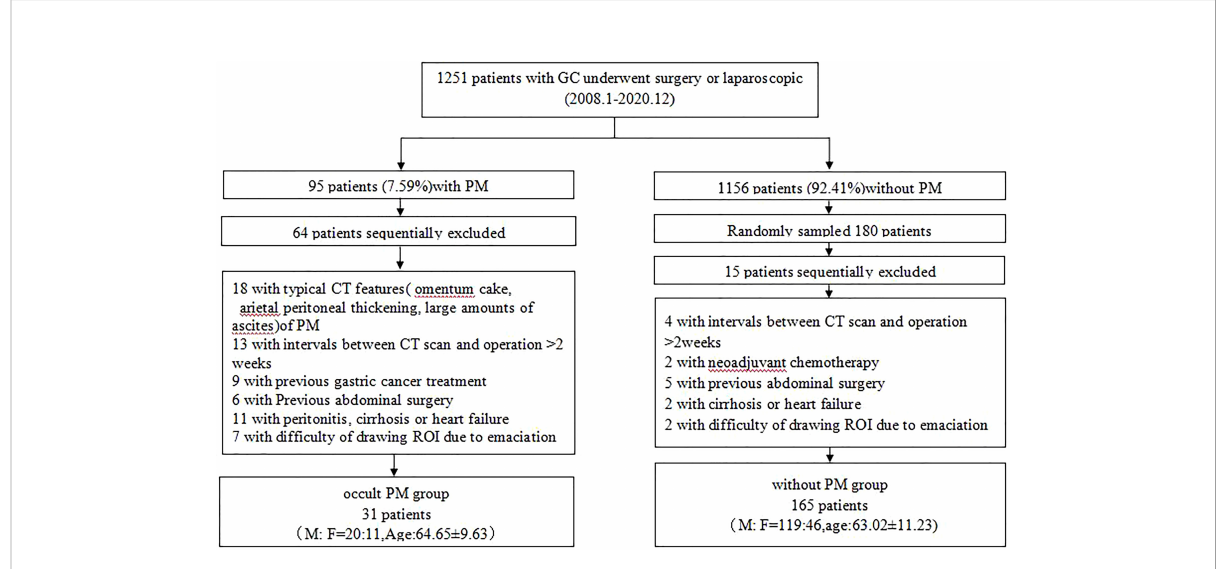
FIGURE 1 Flowchart of study subject